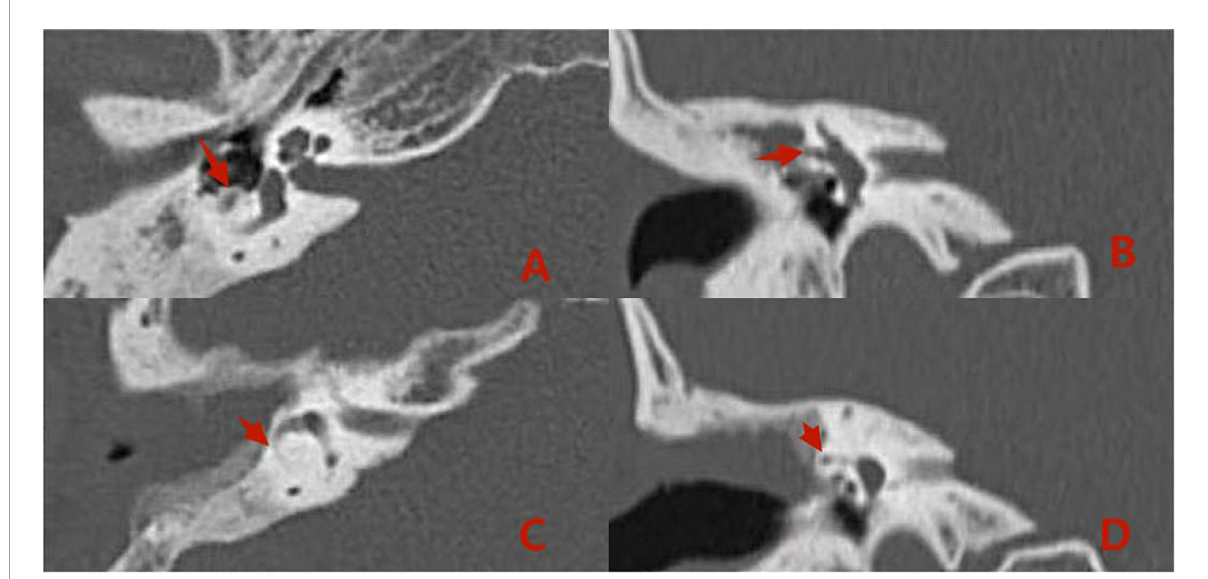
FIGURE5 Computed tomography (CT) images acquired (A,B) preoperatively from a patient with type I labyrinthine fistula. Preoperative (A,B) : The right cholesteatoma is adjacent to bone resorption, the boundary with the external semicircular canal is unclear, and the shape of the external semicircular canal is acceptable (the red arrows). Postoperative (C,D) : The cholesteatoma has been removed, the shape of the lateral semicircular canal is acceptable, and intraoperative fillers are applied to fill the external semicircular canal (the red